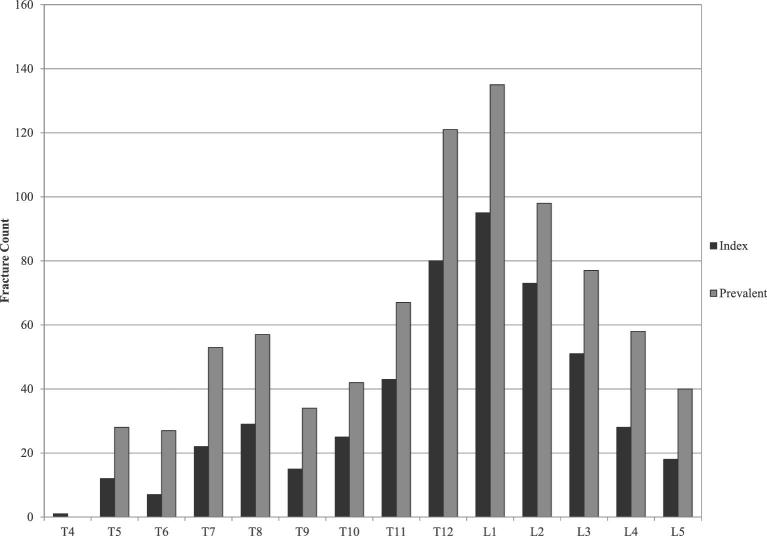
Distribution of index and prevalent fracture levels. Index levels (those identified by investigators as treatment levels) and prevalent fractures (all radiographic fractures assessed by the core laboratory) are shown; prevalent fractures were identified from standing lateral x-ray films with 344 of 350 treated patients contributing data.